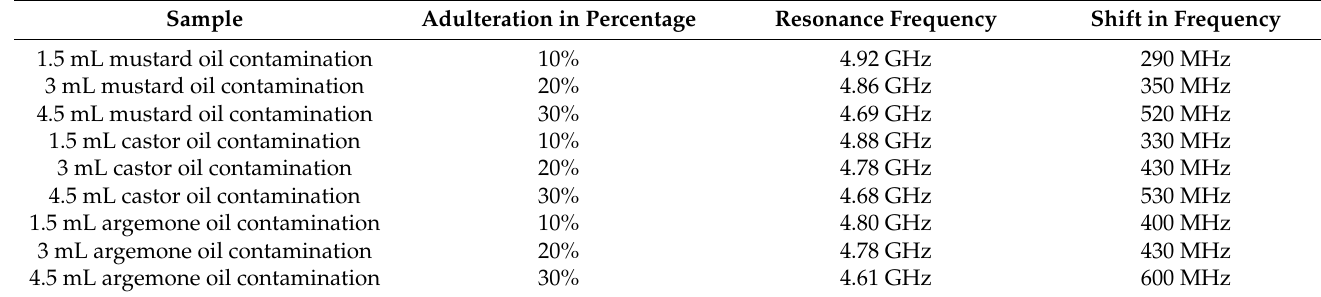
Figure 5. Result of S 21 after adulteration of mustard oil in olive oil. ( a ) Result of S 21 after adulteration of mustard oil in olive oil. ( b ) Result of S 21 after adulteration of castor oil in olive oil. ( c ) Result of S 21 after adulteration of mustard oil in olive oil. ( d ) Resonant frequency at different values of adulteration. Table 4. Shift in resonance frequency compared with pure olive oil in different samples.